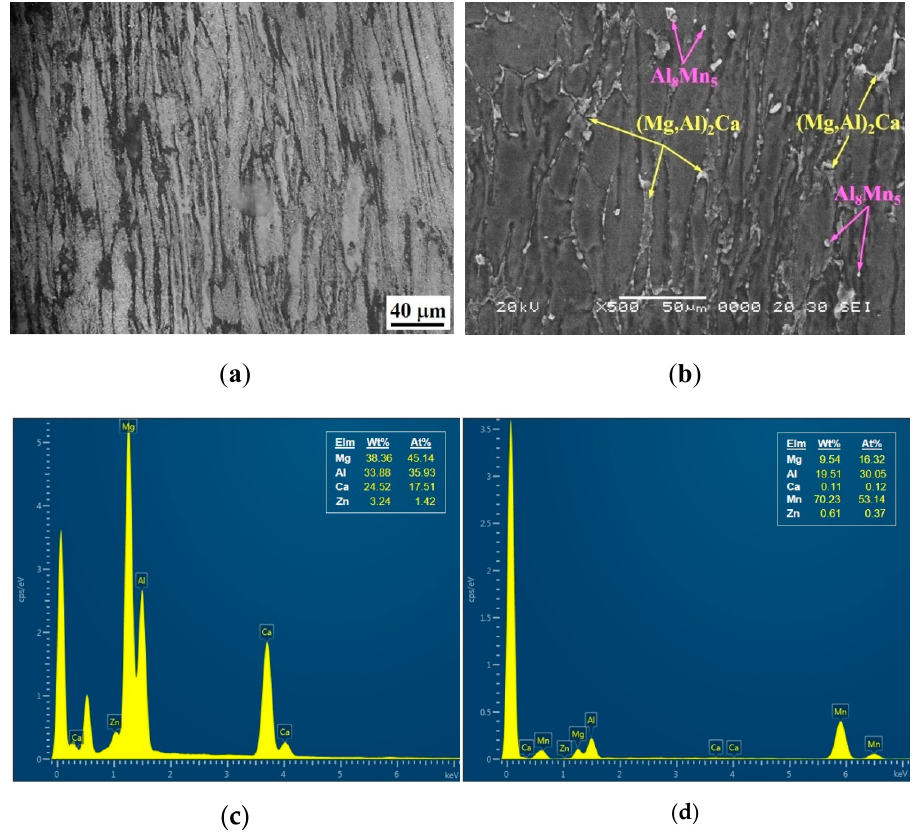
Figure 1. Starting microstructure of disintegrated melt deposition (DMD)-processed AZ31-3Ca. ( a ) Optical, ( b ) scanning electron microscope (SEM) micrograph, and ( c , d ) energy dispersive spectroscopy (EDS) spectra at locations of intermetallic